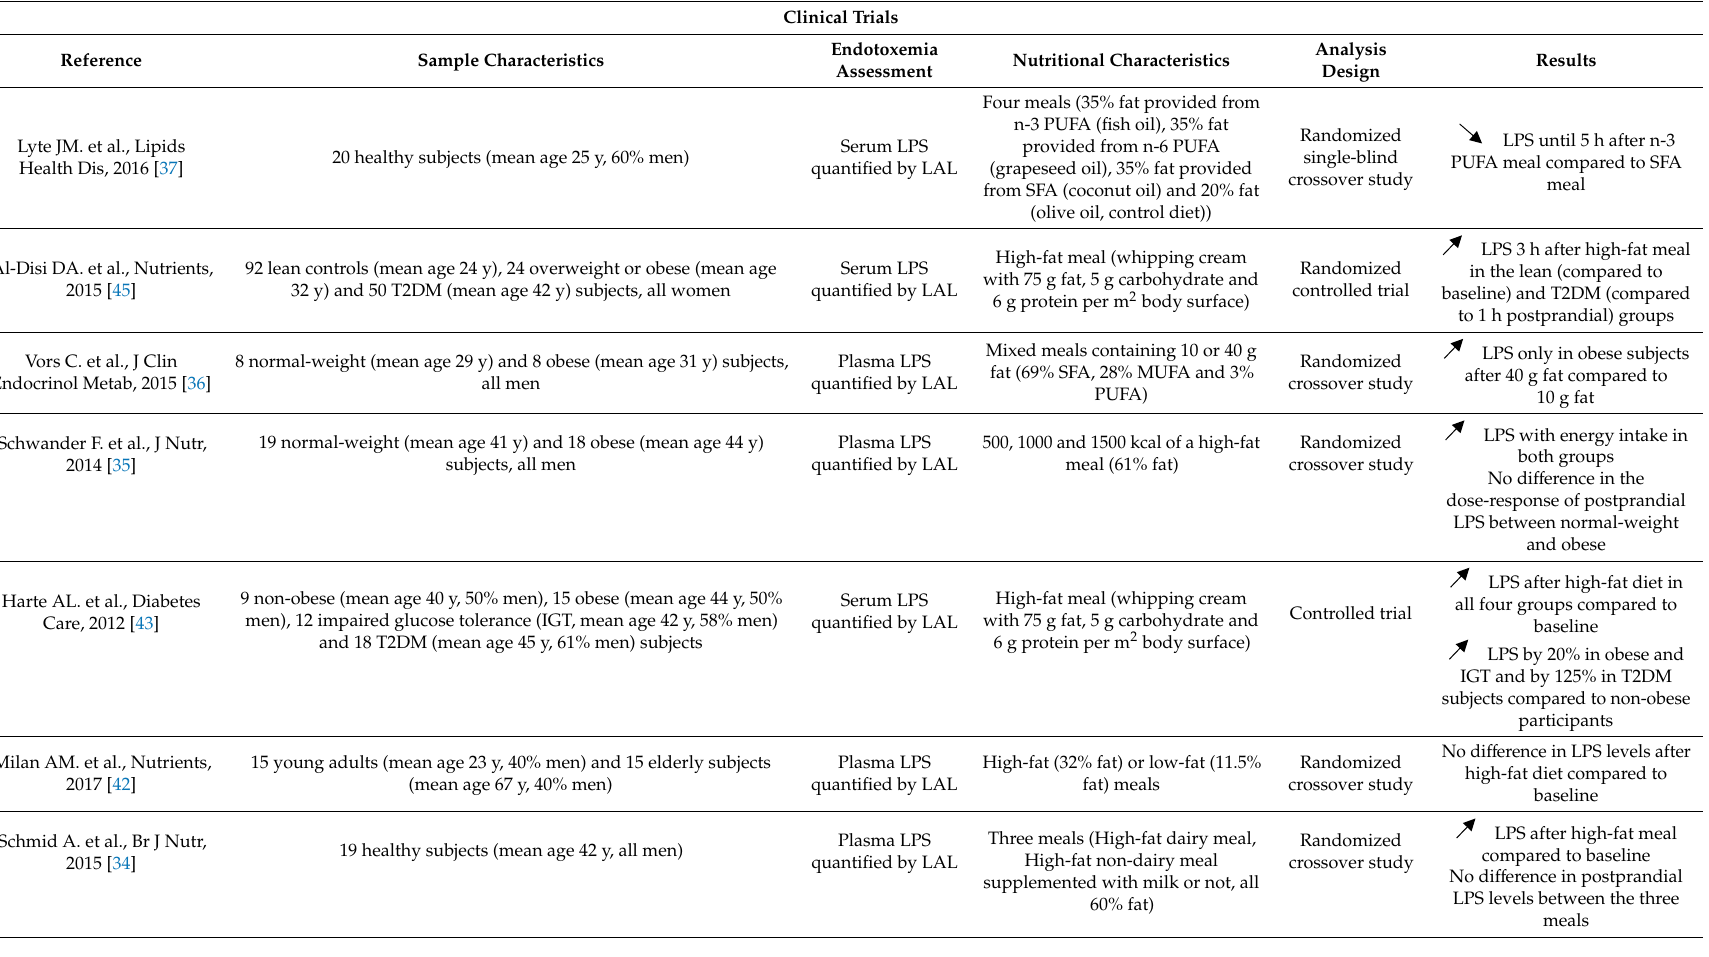
Table 1. Selective evidence on the association between a single high-fat meal and metabolic endotoxemia.